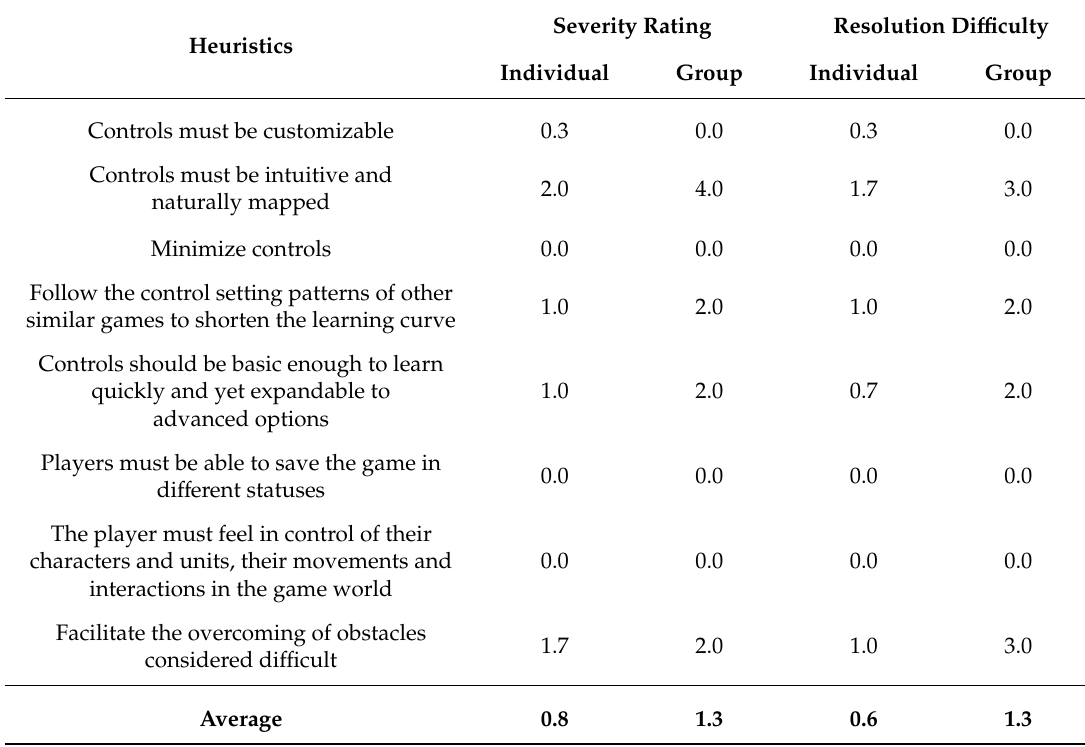
Table 7. Heuristics analysis of the game’s controls [38].